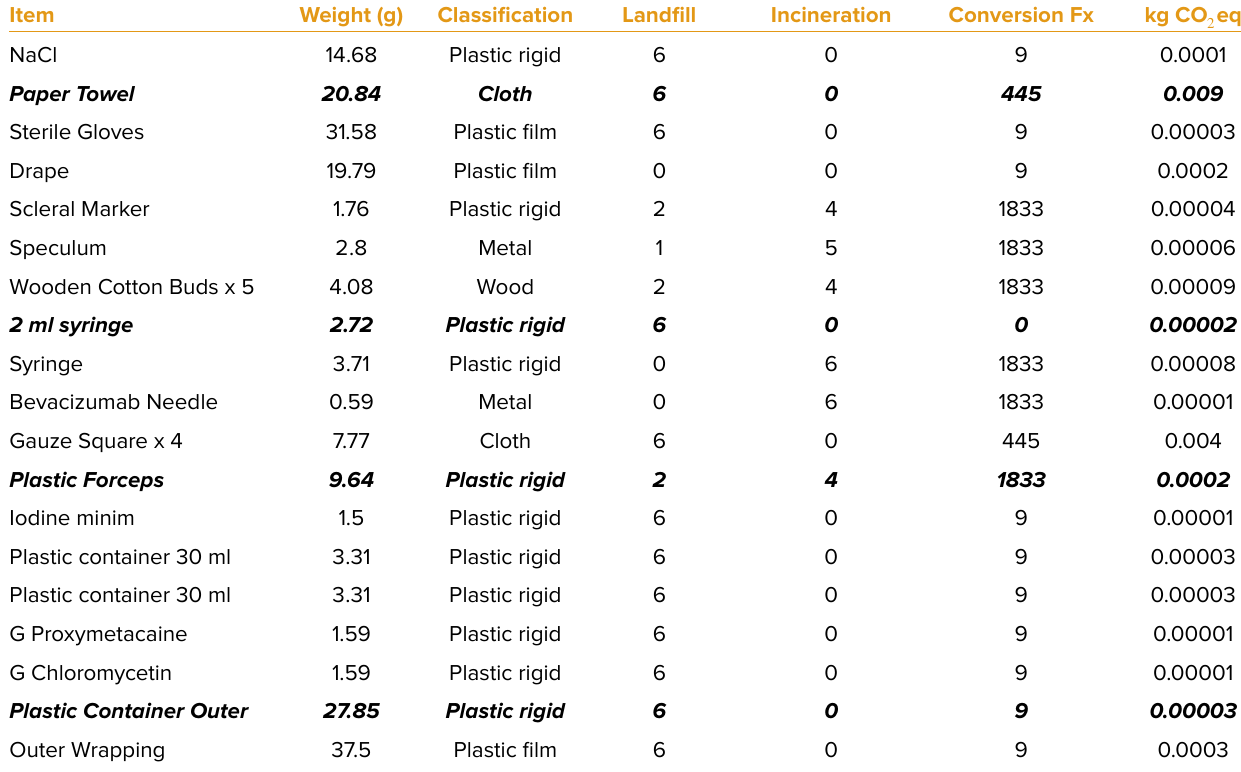
Table 3. Intravitreal injection pack contents and waste disposal emission